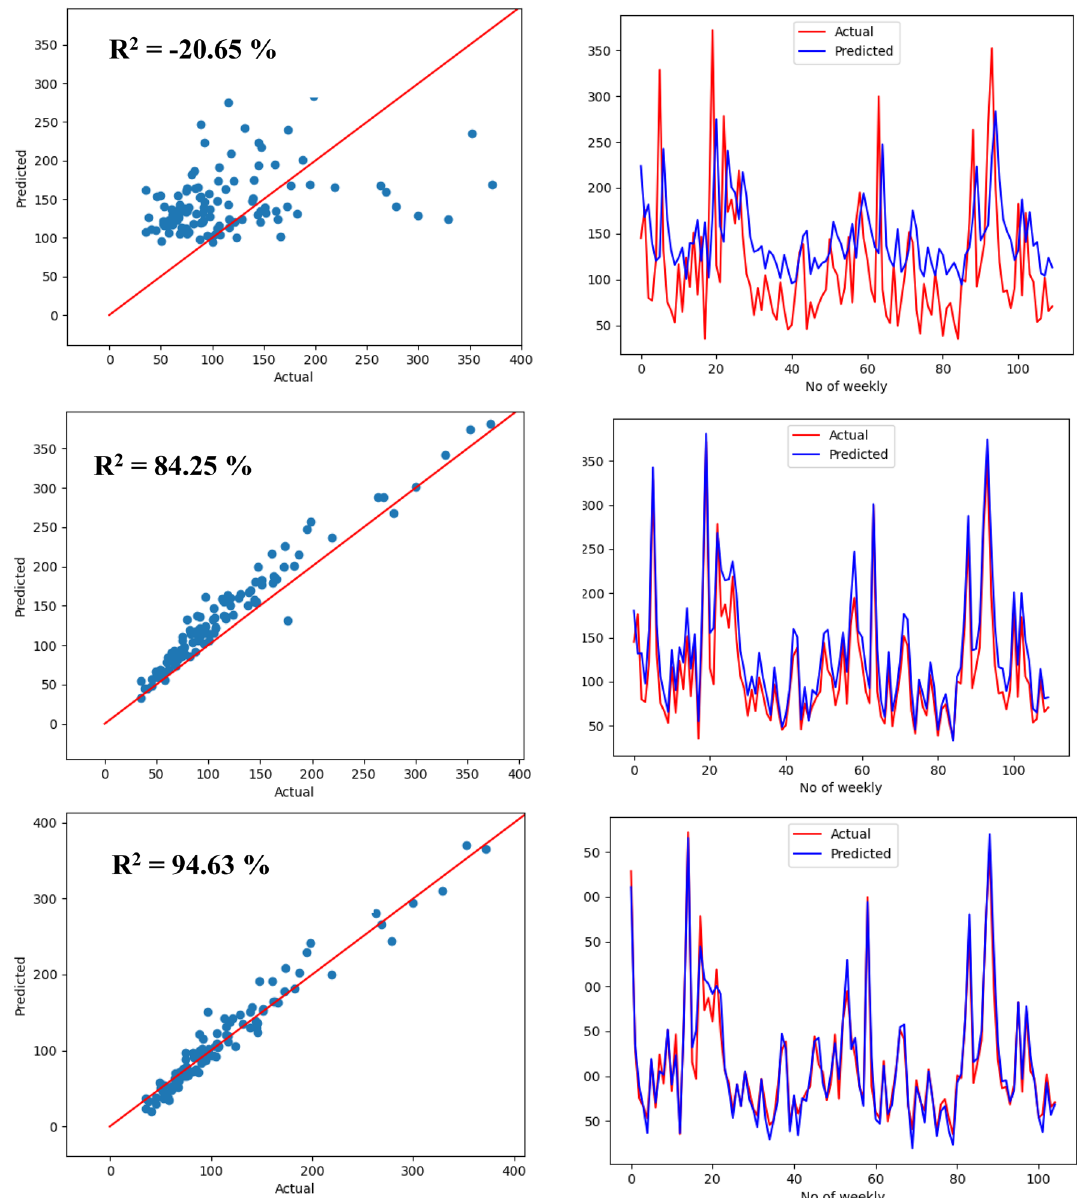
Figure 16. Scatter plot and signal plot of actual sediment versus forecasted sediment for ElasticNet LR for the weekly scenario for different inputs: sediment only (first row), discharge only (second row), sediment and discharge (third